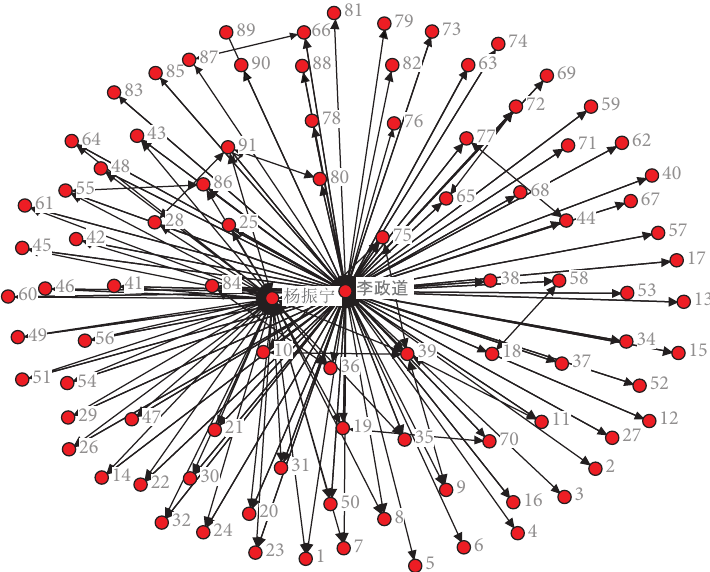
Figure 1: TD Lee scientist cooperation network.